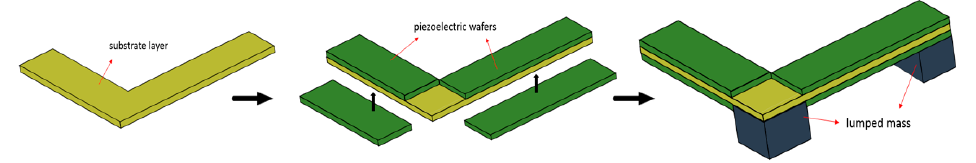
Figure 6. Fabrication process of the harvester.